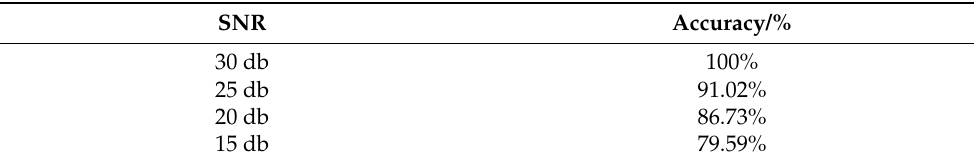
Table 11. Accuracy under different